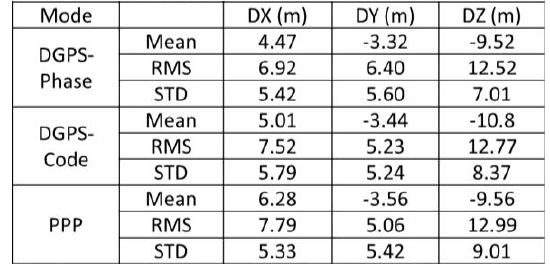
Table 3 Performance summary of proposed multi-rotor UAV platform in GCP free